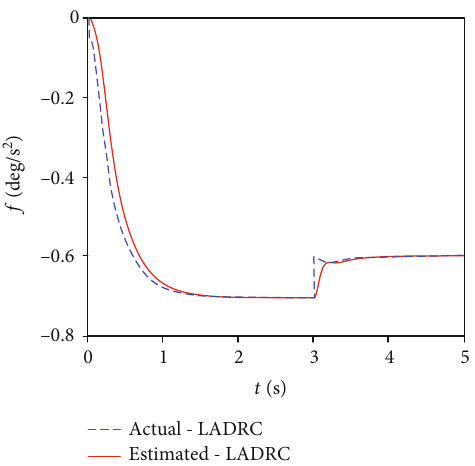
Figure 15: Estimation of f with